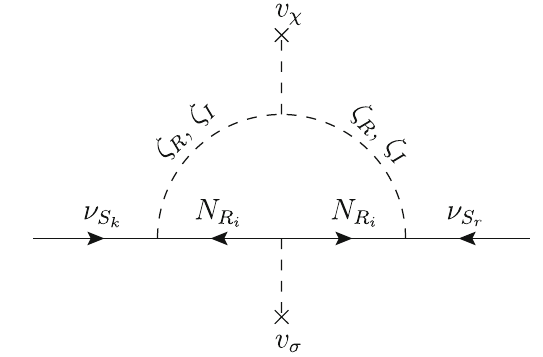
Fig. 1 Feynman diagram for the generation of the Majorana neutrino mass μ via a loop involving the new particles from the dark sector, N R and ζ . The indices run as follows: i = 1 , 2 , 3 and k , r = 1 ,